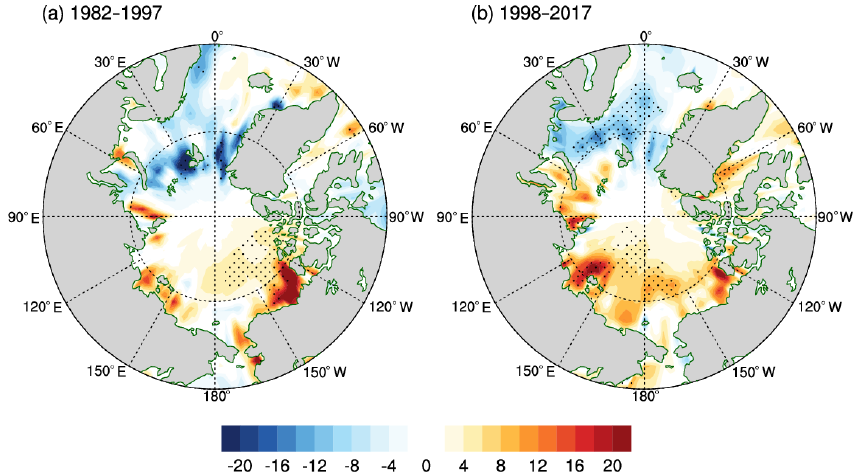
Figure 7. Regression patterns of net surface heat flux (sensible + latent + net shortwave + net longwave, Wm − 2 ) onto the AD index for (a) the early (1982–1997) and (b) the recent (1998–2017) period. The heat flux is defined as positive for the downward trend, and the AD index is reversed in sign to represent the melting phase of sea ice. The dotted area indicates the statistically significant region at the 95% confidence level.